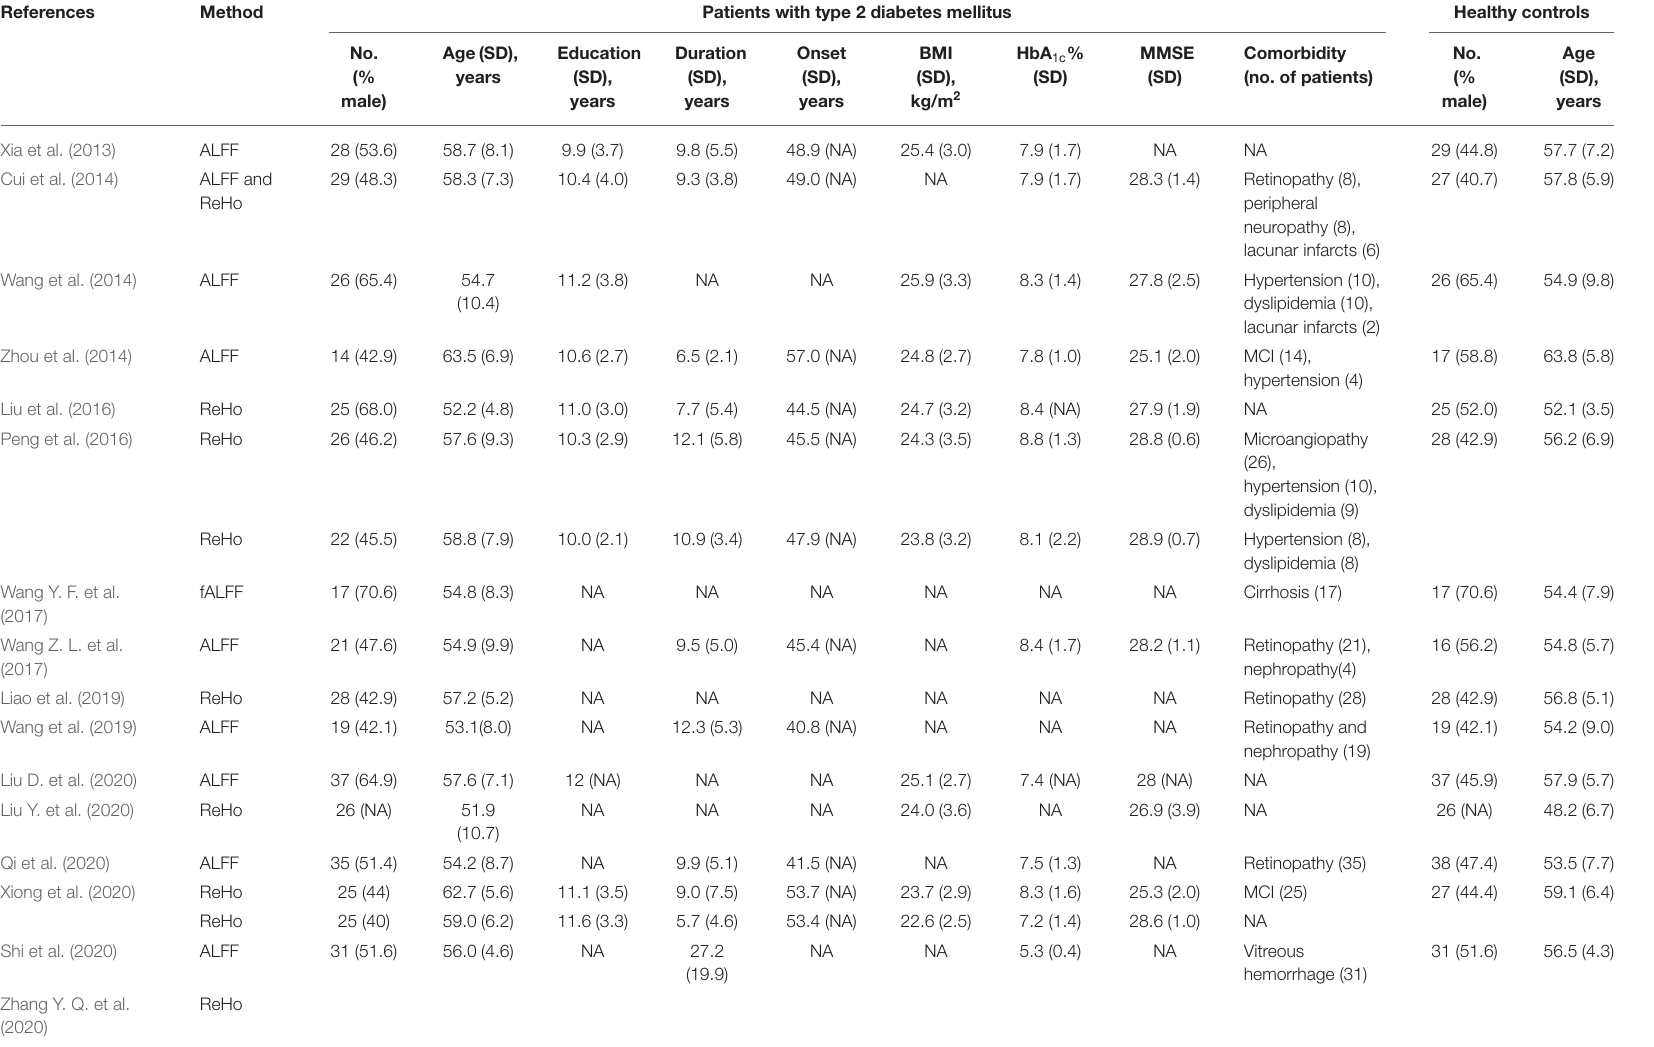
TABLE 1 | Demographic and clinical characteristics of the included studies in the